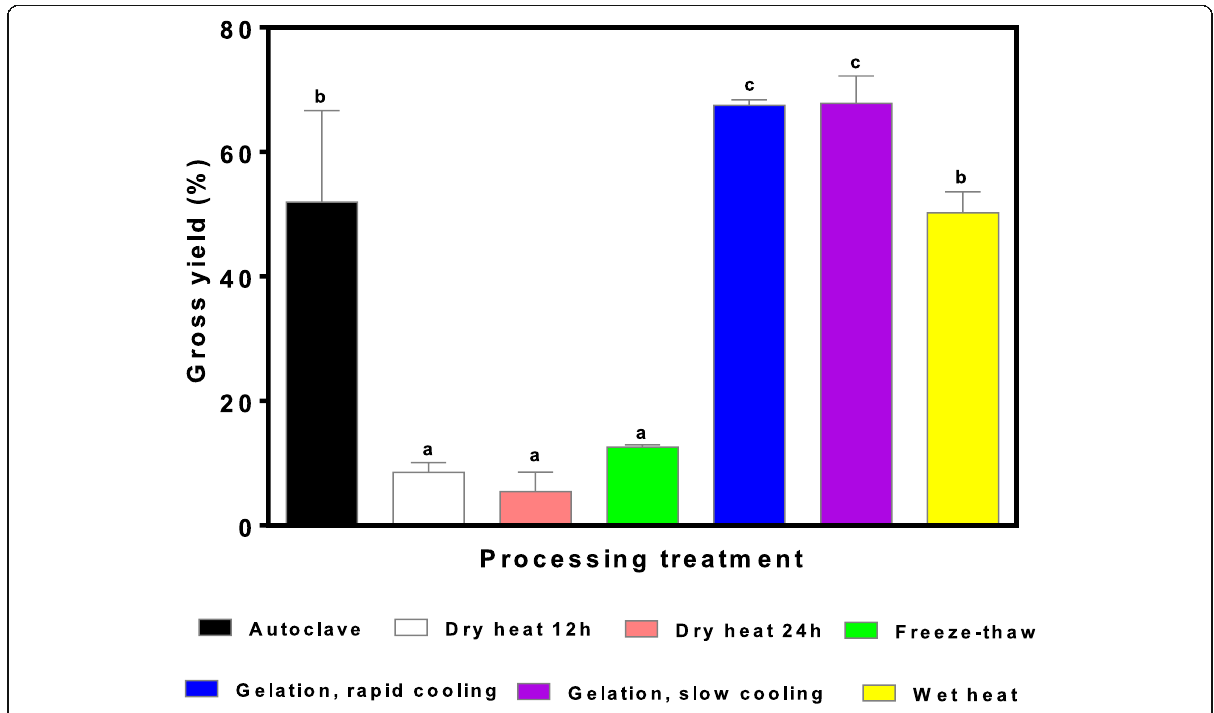
Fig. 1 Percentage gross yields of indigestible cowpea proteins obtained after pepsin + pancreatin digestion of cowpea protein isolate pretreated with autoclave, 12 h dry heat, 24 h dry heat, freeze-thaw (3 cycles), gelation (rapid cooling), gelation (slow cooling) and wet